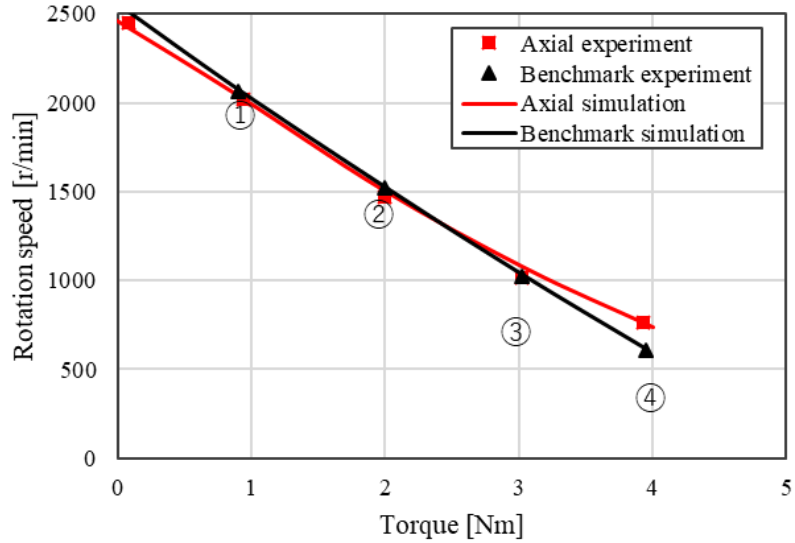
Figure 23. Operation characteristics of designed motor and benchmark motor.